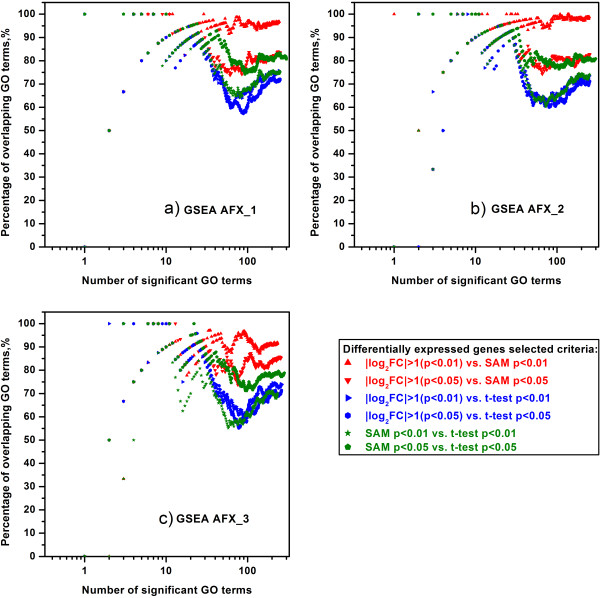
The concordance of significant GO terms enriched by GSEA within the same test site of AFX. The comparisons of significant GO terms enriched by GSEA were conducted within a) AFX_1; b) AFX_2; c)AFX_3. Two DEG lists generated by fold change ranking, two DEG lists generated by SAM and two DEG lists generated by t-test were inputted in GSEA to enrich significant GO terms (FDR < 0.25). And then the concordance of two significant GO terms lists derived from two DEGs selected methods was compared on the same p-value cutoff. The red markers reflect the percentages of overlapping GO terms by using fold change ranking and SAM for generating DEG lists. The blue markers reflect the percentages of overlapping GO terms by using fold change ranking and t-test for generating DEG lists. The olive markers reflect the percentages of overlapping GO terms by using SAM and t-test for generating DEG lists. The _1, _2 and _3 suffixes refer to test site location.